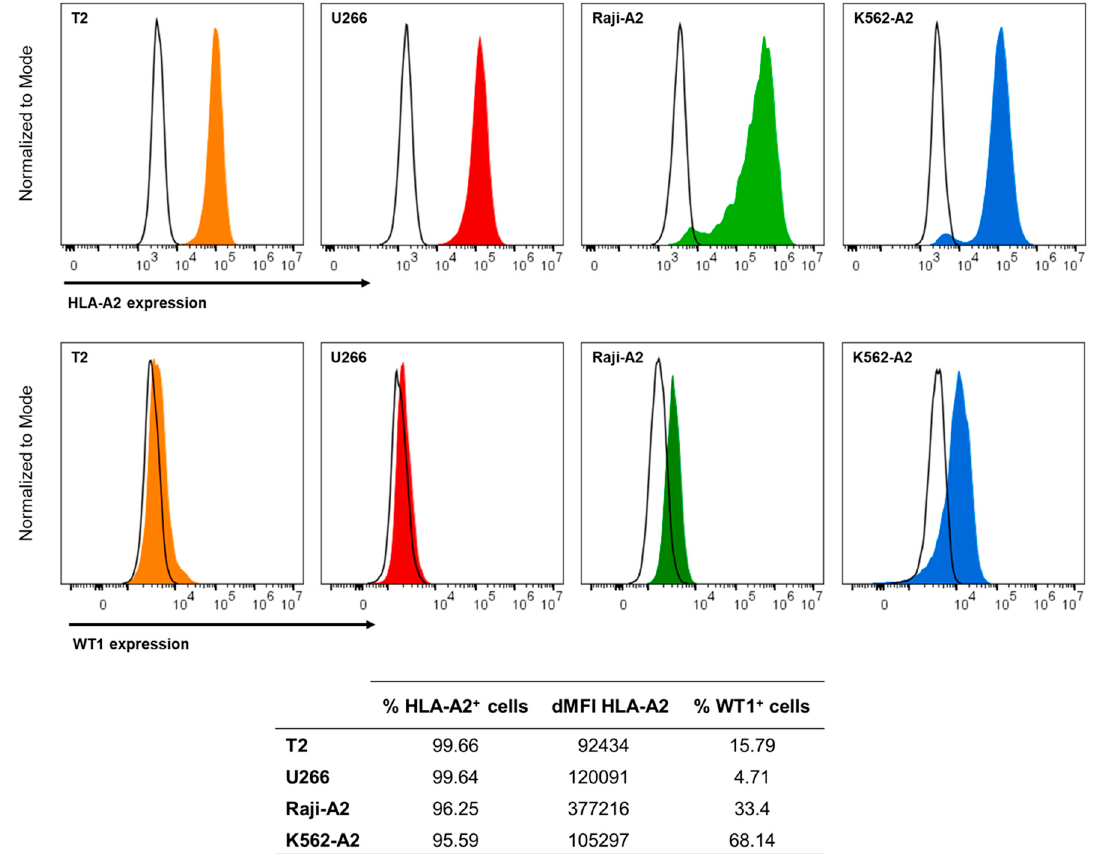
Figure 1. HLA-A2 and WT1 expression on four model antigen-presenting cell (APC) lines. Histograms (relative to mode) show the surface expression of HLA-A2 (upper panel) and the intracellular expression of WT1 (lower panel) of T2 (orange), U266 (red), Raji-A2 (green), and K562-A2 (blue) cell lines. HLA-A2 or WT1 expression (filled histograms) and isotype control (black line). The table shows HLA-A2 delta median fluorescence intensity (dMFI) values and percentage of HLA-A2 positive cells minus isotype staining (upper histograms) or percentages of WT1 positive cells minus isotype staining (lower histograms) for each cell line. HLA-A2, human leukocyte antigen A*02:01; WT1, Wilms’ tumor 1 protein.